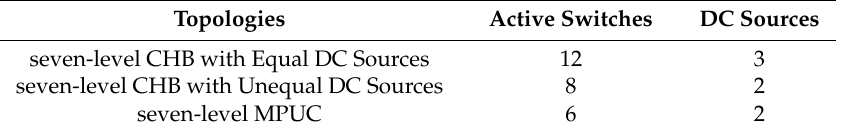
Table 4. Comparison between seven-level MPUC topology and seven-level CHBs inverter.